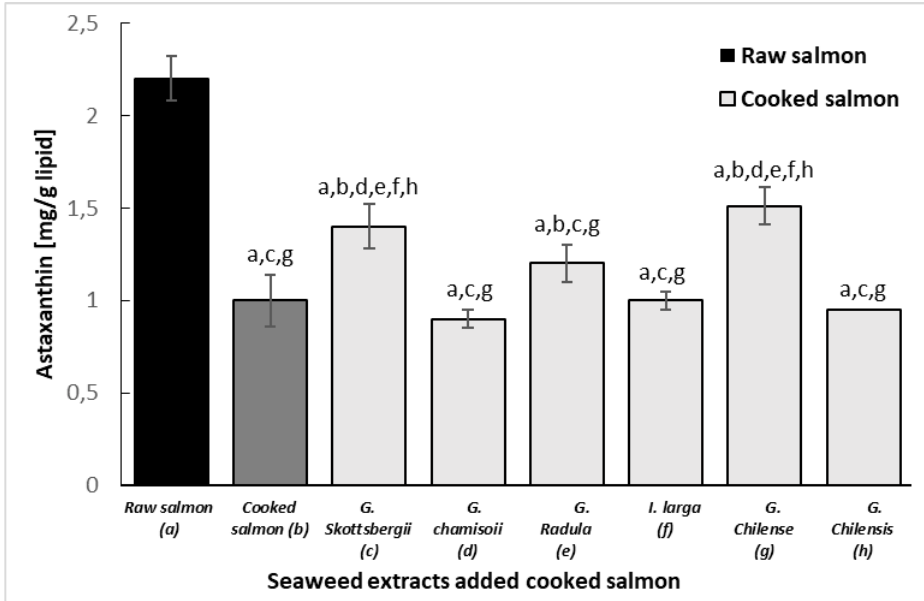
Figure 5. Astaxanthin of cooked and raw salmon pastes added with different extracts of red algae: (a) Raw salmon paste, (b) Cooked salmon paste, (c) G. chamissoi , (d) G. skottsbergii , (e) G. radula , (f) I. larga , (g), G. chilense , (h) G. chilensis . Values are expressed as means ( n = 3) ± standard deviation. Different letters correspond to mean values with significant difference ( p < 0.05).